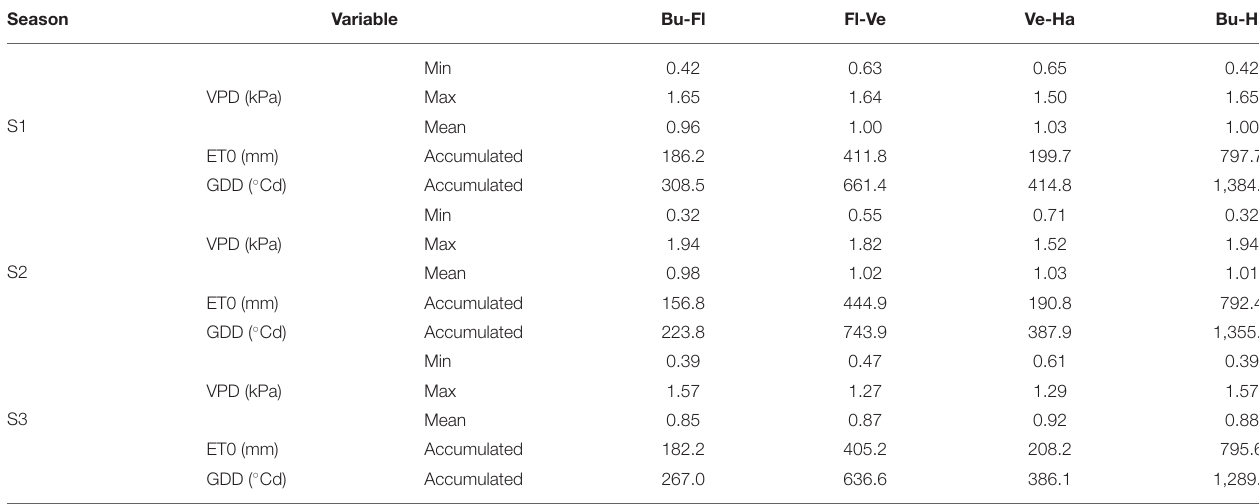
TABLE 1 | Vapor pressure deficit (VPD), reference evapotranspiration (ET0), and growing degree days (GDD) for the main phenological stages of both cultivars during 2018–2019 (S1), 2019–2020 (S2), and 2020–2021 (S3) seasons.